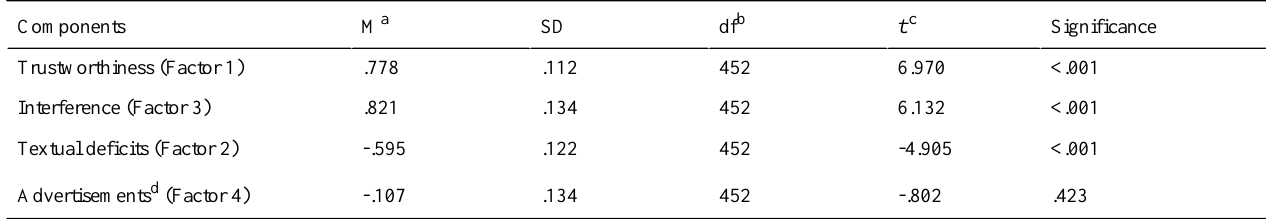
Table 6. Statistical differences between the two